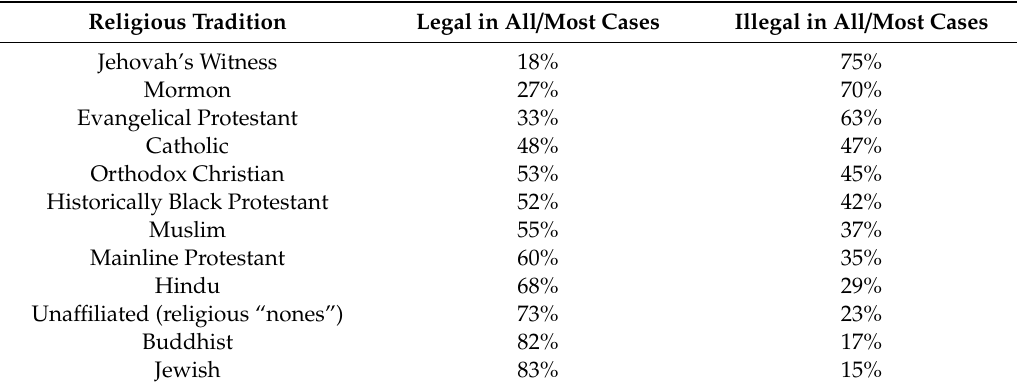
Table 1. Views on Abortion Legality by Religious Group (Adapted from Pew Research Center